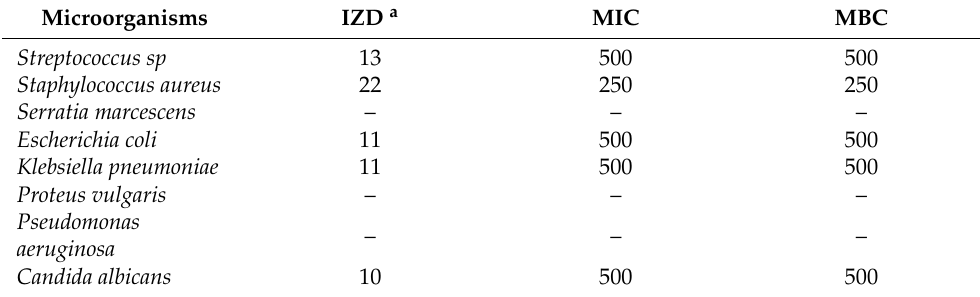
Table 2. Antimicrobial activity of gallic acid (100 µ g/disc) extracted from Ajwa date pits.